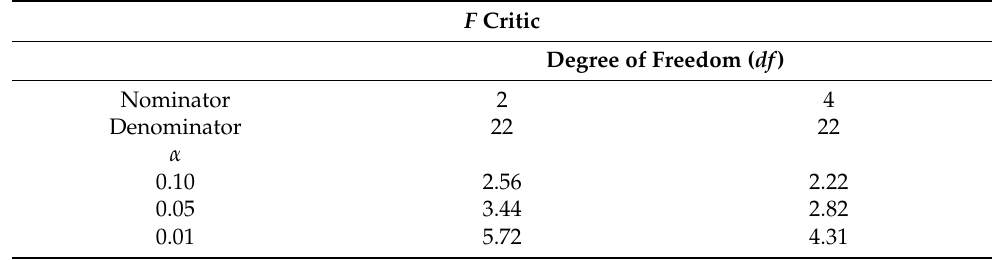
Table 7. ANOVA F critic calculation for